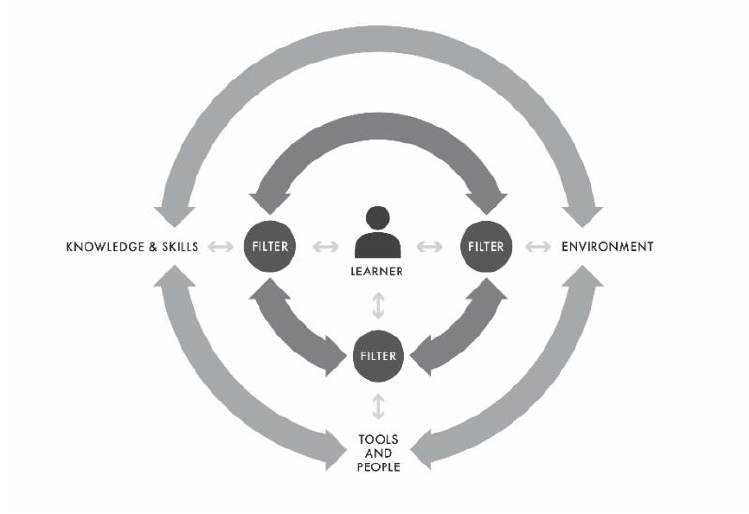
Figure 1 The Ecology of Resources model (Luckin, 2010) including resource elements and their